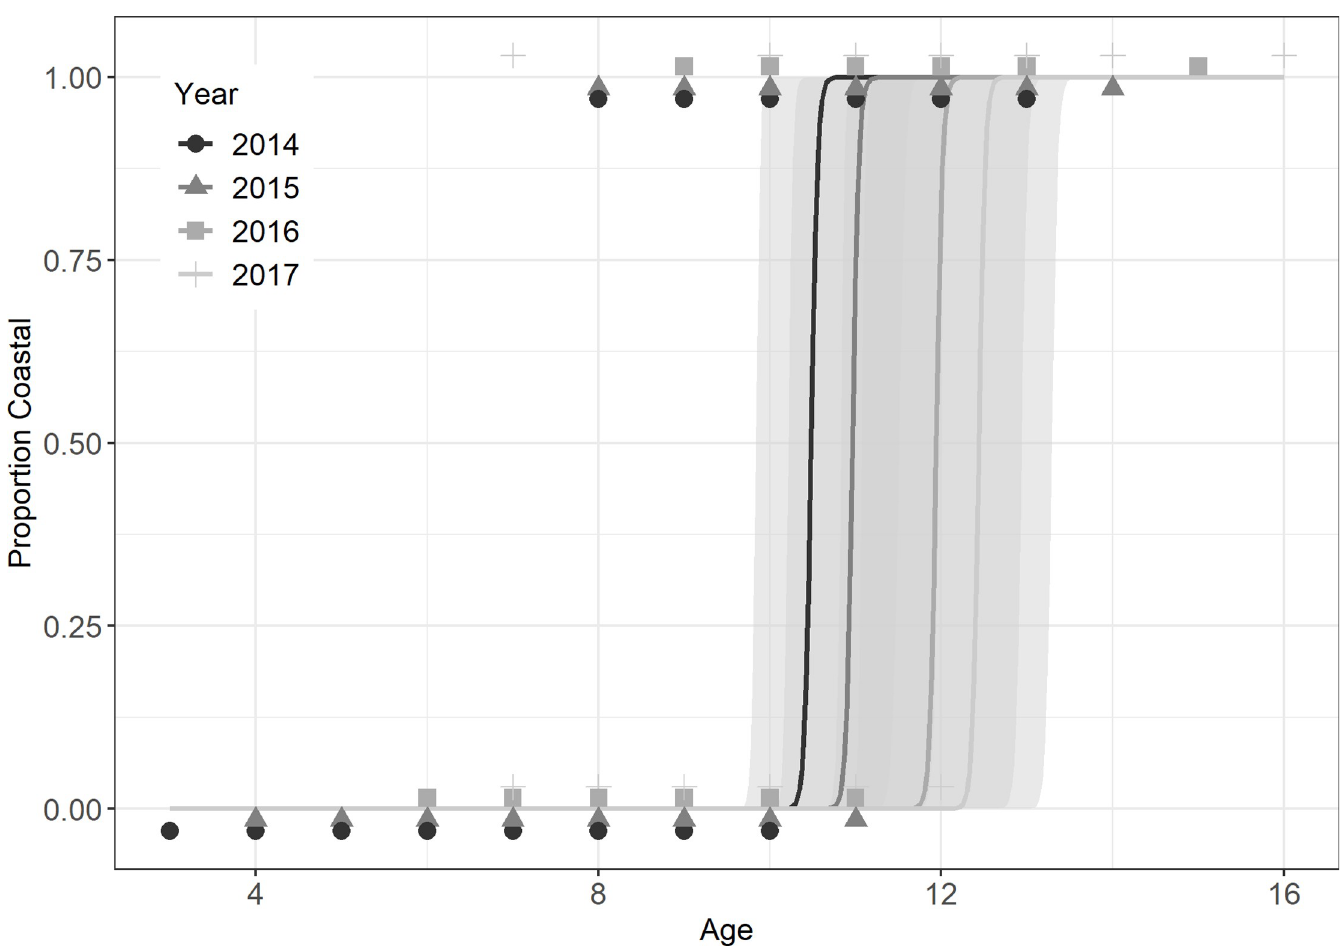
Fig 5. Age-dependent emigration by study striped bass. GLMM fits of ocean incidences versus estimated age for striped bass classified based on positive or nil detections in shelf arrays. 95% confidence interval ellipses are shown.